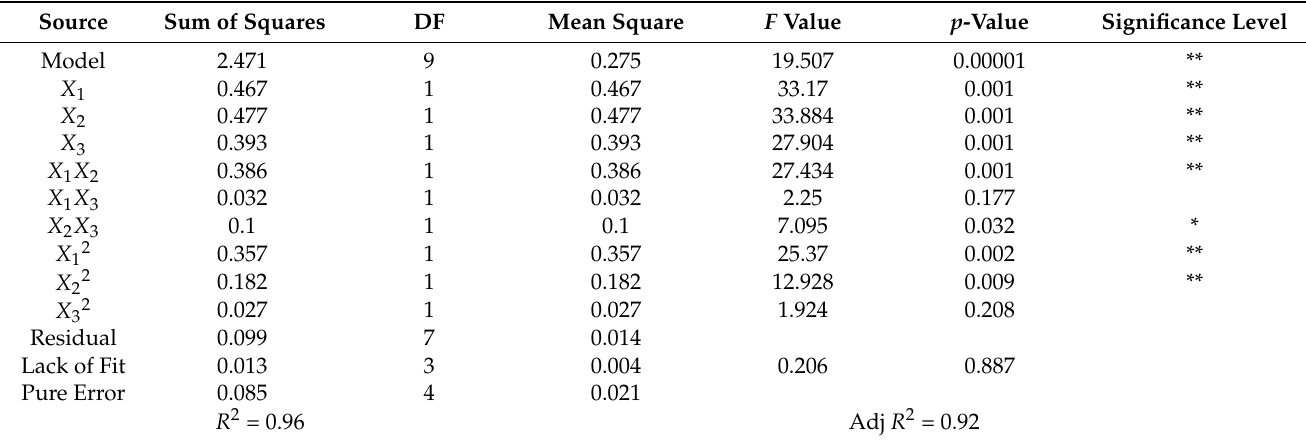
Table 3. Regression model variance analysis